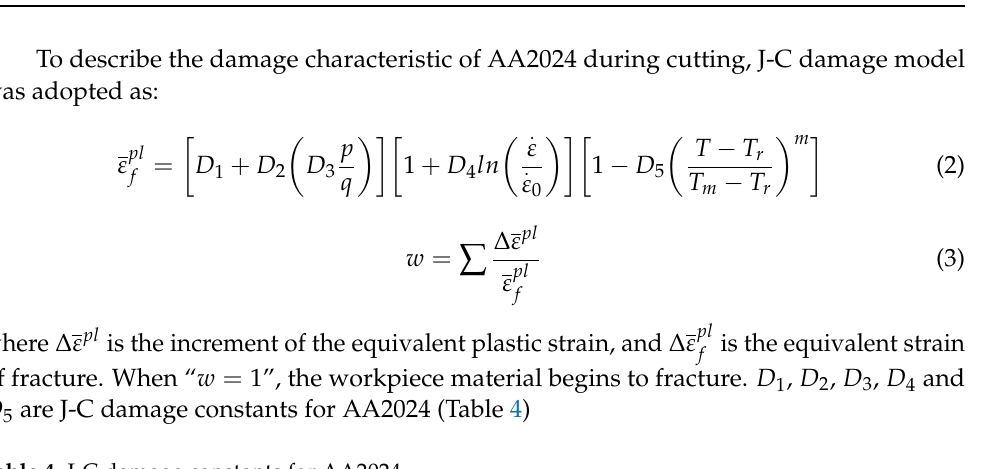
Table 4. J-C damage constants for AA2024.